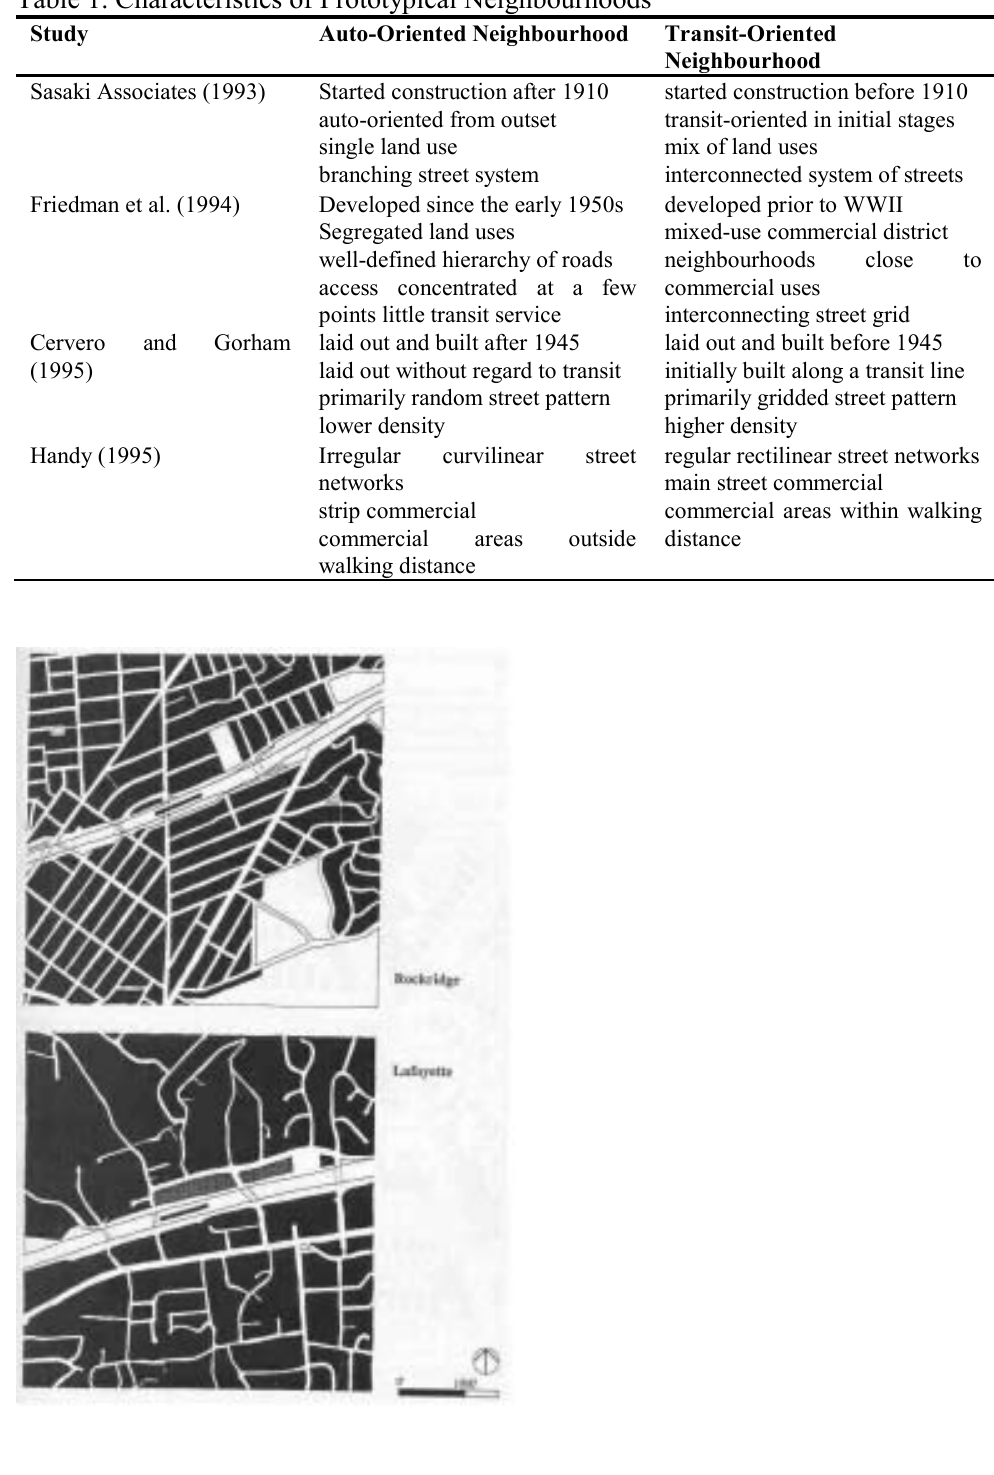
Figure 1. Two Contrasting San Francisco Bay Area Neighbourhoods: Rockridge (Top) and Lafayette